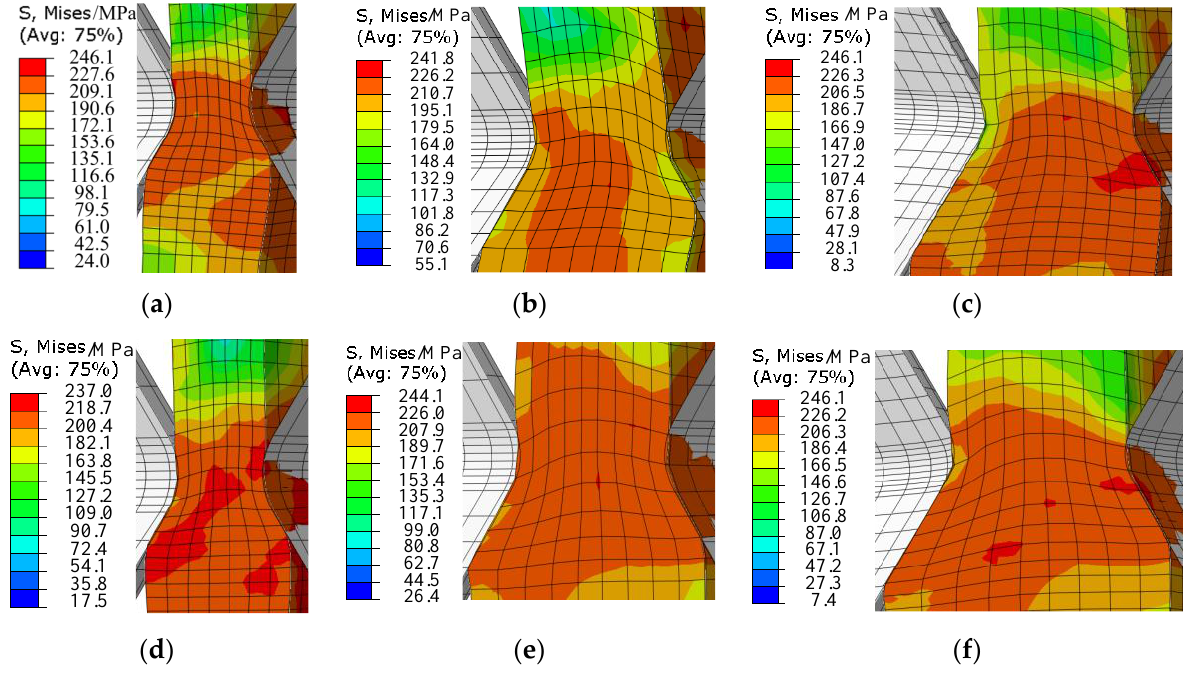
Figure 10. The stress nephograms of the tube deformation region in the CRFF process: ( a ) 10 mm thickness, ACRFF; ( b ) 20 mm thickness, ACRFF; ( c ) 30 mm thickness, ACRFF; ( d ) 10 mm thickness, SCRFF; ( e ) 20 mm thickness, SCRFF; ( f ) 30 mm thickness, SCRFF. The contact region between the roller and the tube increases with tube blank thick- ness. In Figure 10c, the outer roller contact line is 23.29 mm and ~2.84 times the inner roller contact line length in the 30 mm thick-tube ACRFF process. The outer roller contact line length in the 10 mm thick-tube ACRFF process is 0.28 times that in the 30 mm thick-tube ACRFF process. The primary reason is that more material deforms in the thick tube than